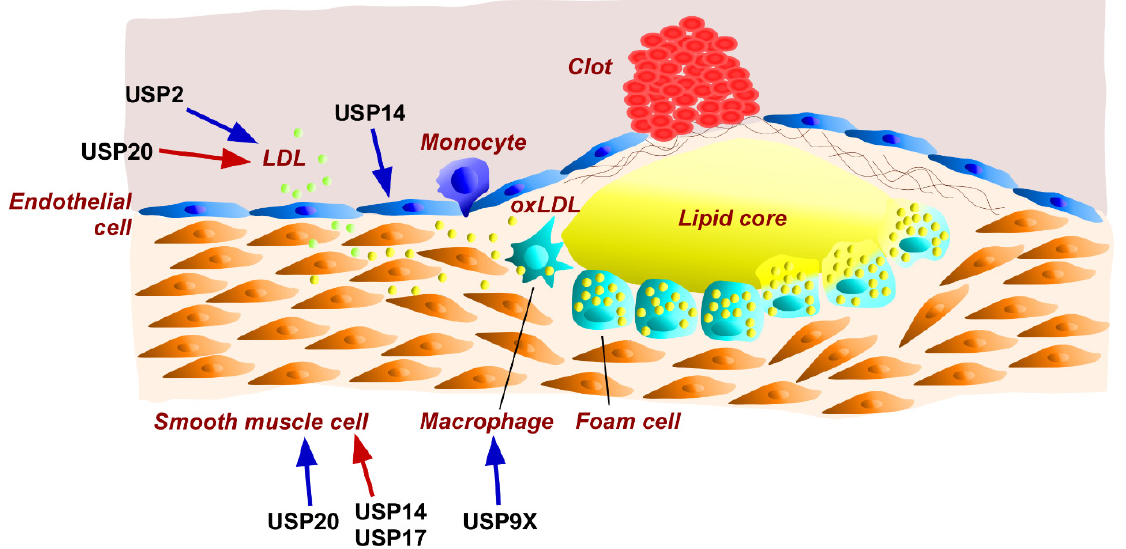
Figure 3. The roles of USPs in atherosclerosis. Blue and red arrows represent restorative and deteriorative effects, respectively, on atherosclerosis. oxLDL stands for oxidative LDL. Surface expression of the LDL receptor (LDLR) in the liver is one of the determinants of blood LDL levels [212]. The inducible degrader of LDLR (IDOL) is an E3-ubiquitin lig- ase that selectively catalyzes the ubiquitination of LDLR [213]. Since overexpression of Usp2 promotes the deubiquitination of IDOL, USP2 was considered to suppress LDL up- take via ubiquitin-dependent degradation of LDL [212]. However, the USP2-induced